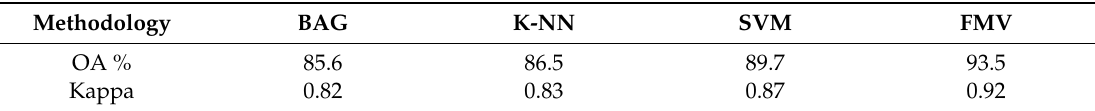
Figure 6. The number of the correct spices classified by each classifier for benthic cover mapping. Table 2. The overall accuracy (OA) and Kappa results of all methods for benthic habitat classification for Shiraho area.